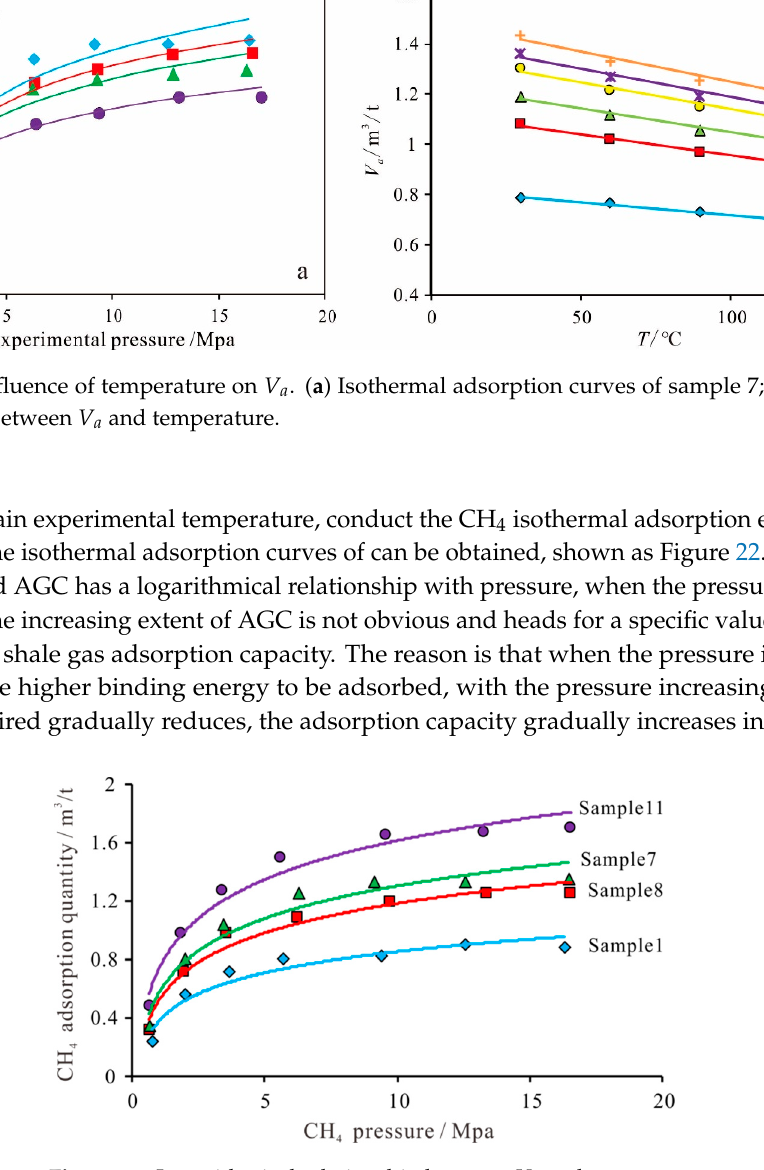
Figure 22. Logarithmical relationship between V a and pressure.